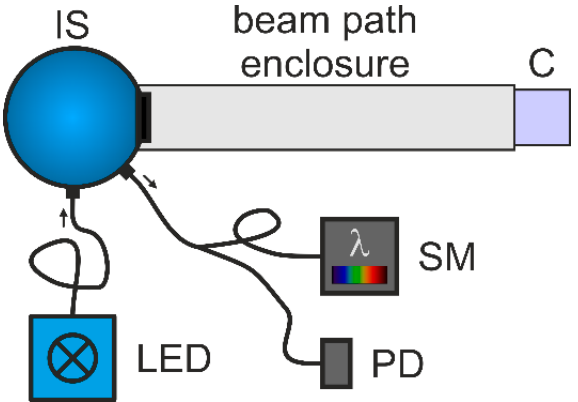
Figure A3. Schematic drawing of the experimental setup to characterize the camera according to the EMVA 1288 standard. LED: light-emitting diode, IS: integrating sphere, PD: reference photodiode, SM: spectrometer, C: camera.